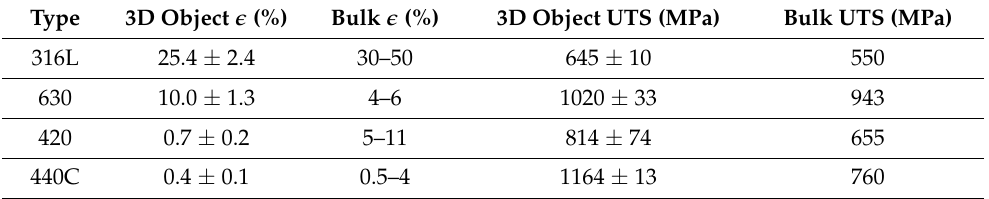
steel tensile specimens. Table 7. Elongation and ultimate tensile strength for each steel-type 3D object, compared to bulk [34].